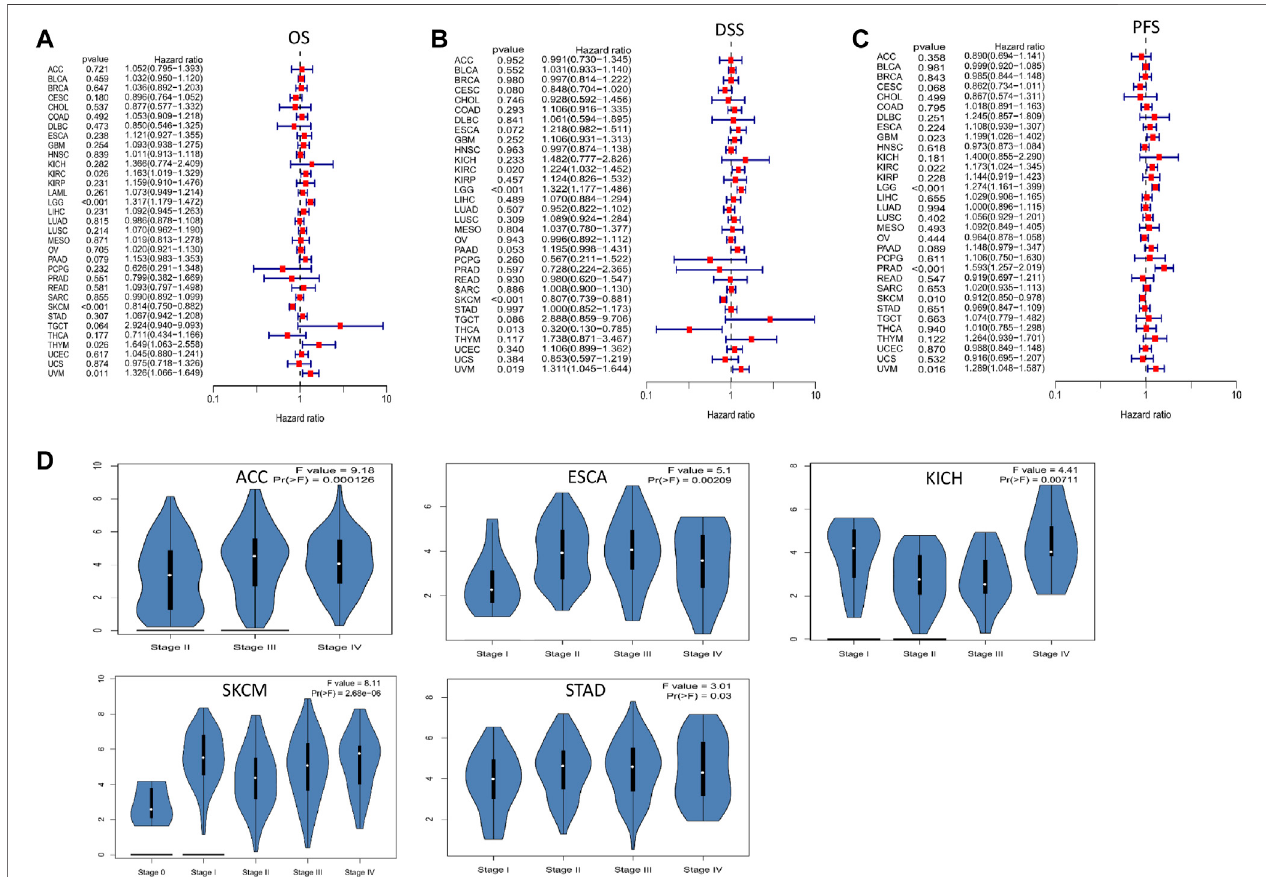
FIGURE3| TheassociationbetweenFCGR3Aexpressionlevelsandprognosisandtumorpathologicalstage. (A) Overallsurvival(OS); (B) Diseasespeci fi csurvival (DSS); (C) Progression-free survival (PFS); (D) Differential expression of FCGR3A in different stages.